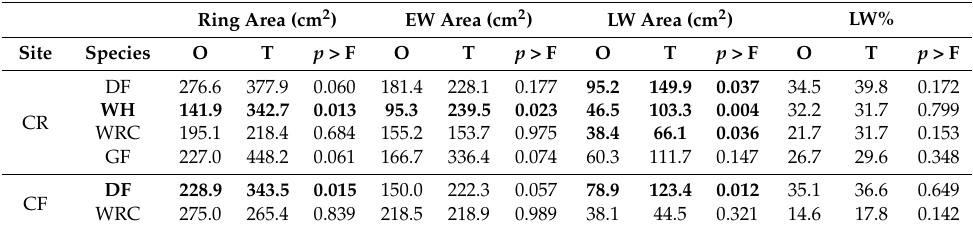
Table 6. Least Square Means for whole-tree total ring area, earlywood area (EW), latewood area (LW) and latewood percentage (LW%) for Douglas-fir (DF), western hemlock (WH), western redcedar (WRC), and grand fir (GF) trees growing under contrasting vegetation management treatments on sites located in the Cascade foothills (CF) and the central Coast Range (CR) of western Oregon. Bold : result is statistically significant at p < 0.05 or p <